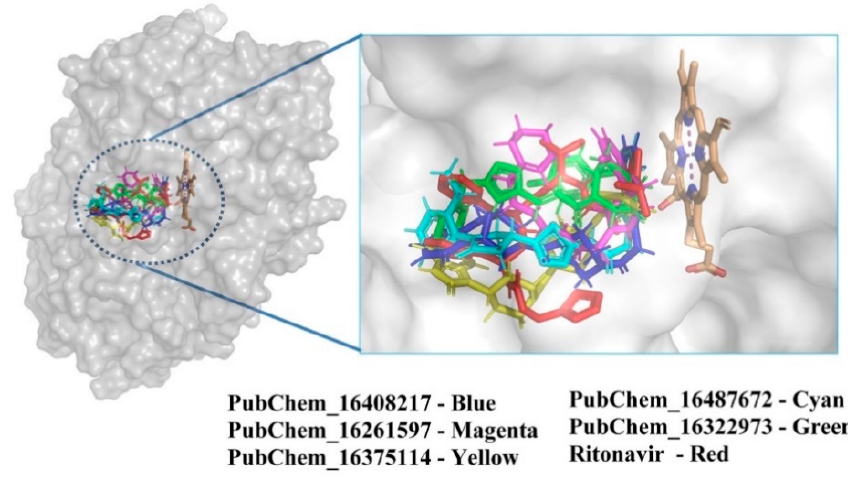
Figure 7. Position of CYP3A5 molecules inside the receptor cavity; a surface view representation.